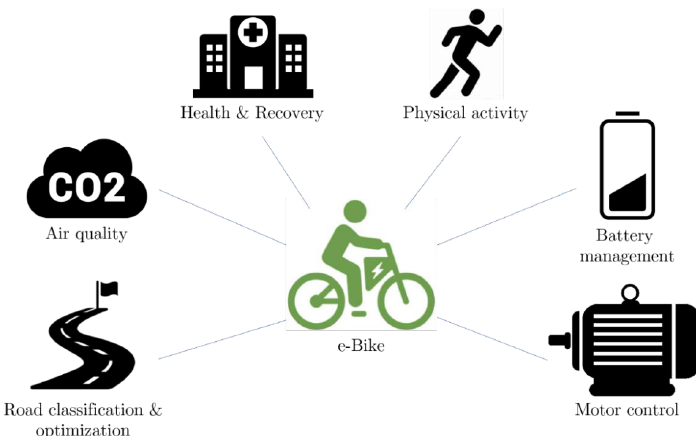
Figure 2. Electrically assisted bikes and associated research